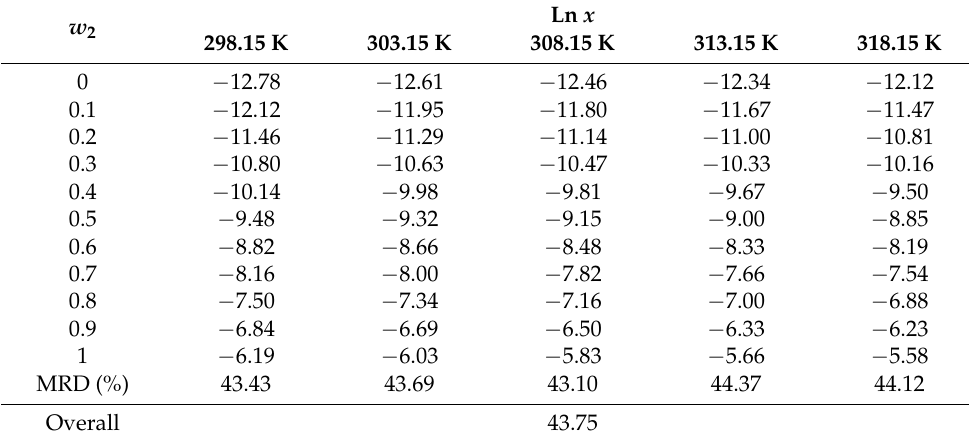
Table 3. Ln x values of the drug calculated by the Yalkowsky model (YM) equation in the THP mixture at different temperatures.